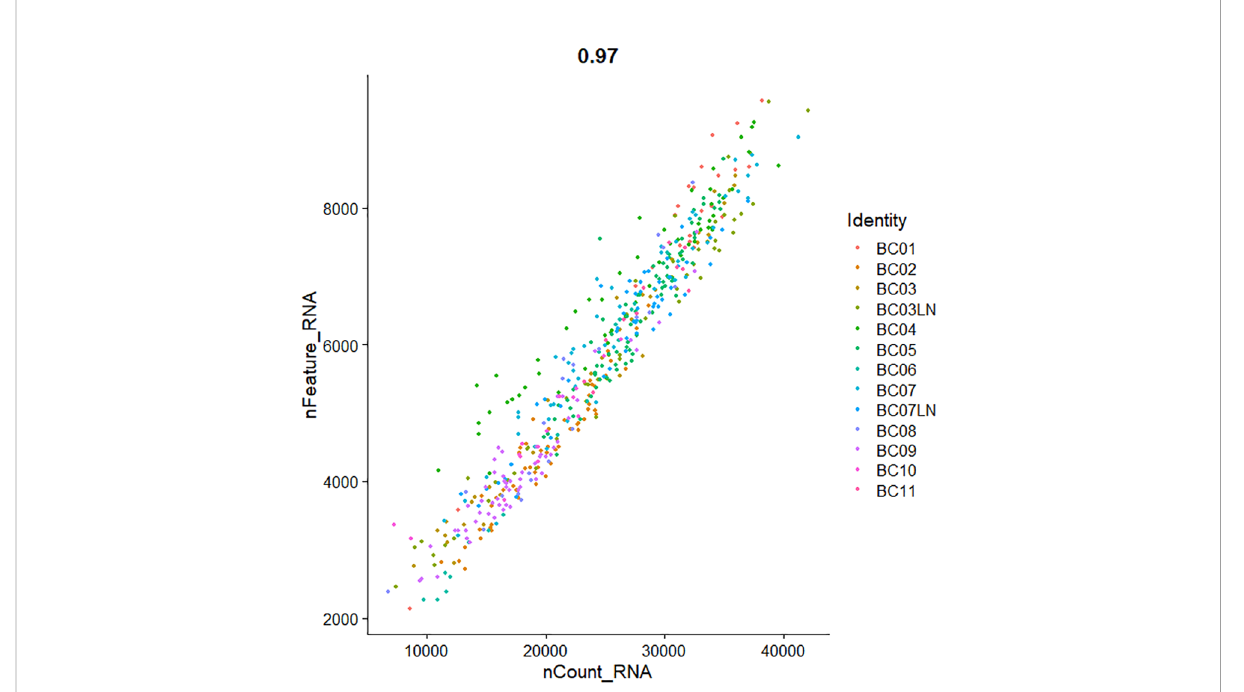
FIGURE 2 The Scatter plot of the feature – feature relationships in GSE75688 dataset after quality control.